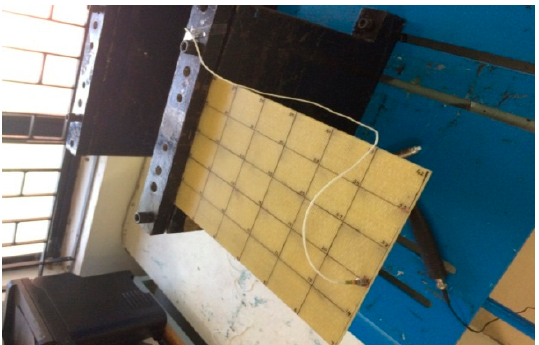
Figure 5. Experimental setup for the CFFF boundary condition.